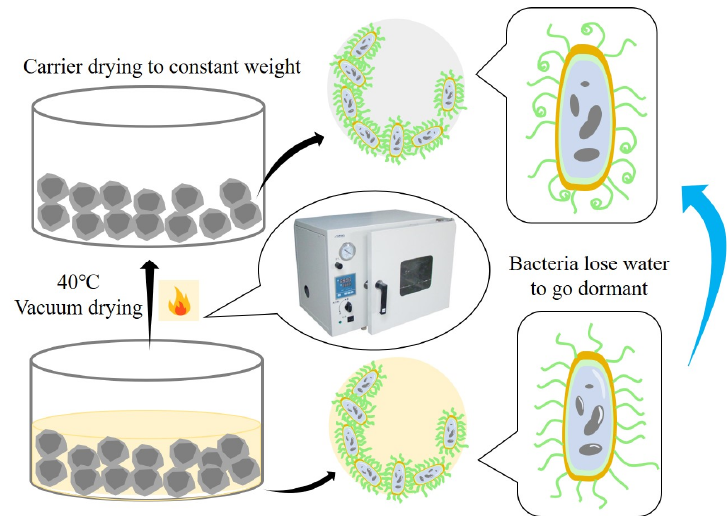
Figure 7. Schematic representation of carrier drying after adsorption.